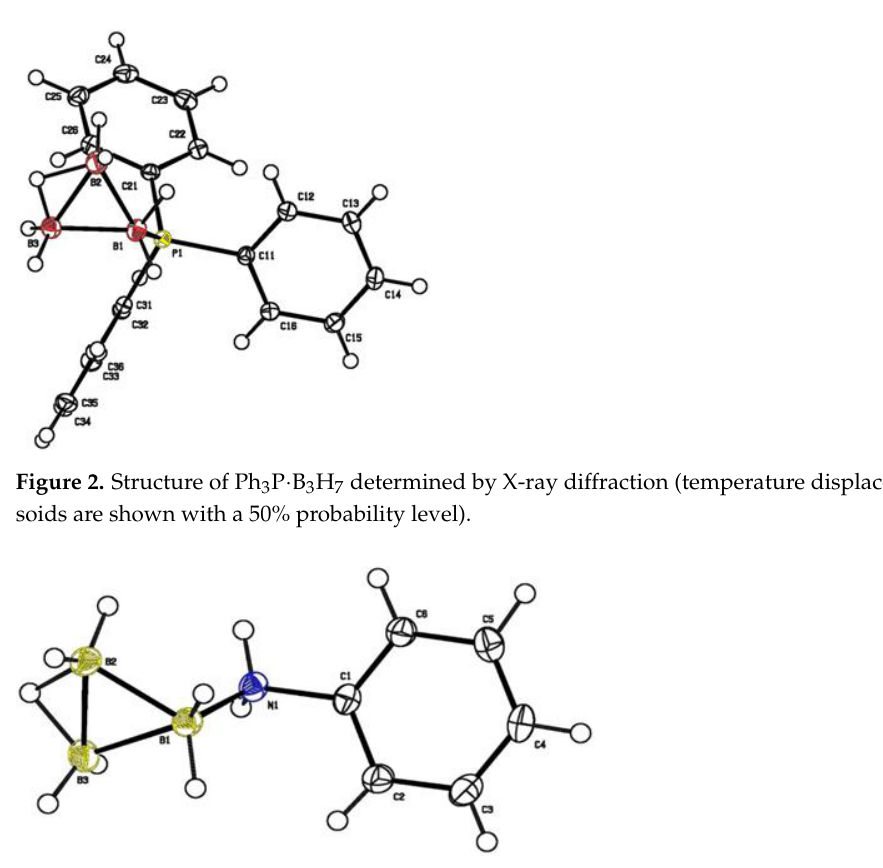
Figure 3. Structure of PhNH 2 · B 3 H 7 determined by X-ray diffraction (temperature displacement ellipsoids are shown with a 50% probability level). Table 1. The structural data obtained for Ph 3 P·B 3 H 7 and PhNH 2 ·B 3 H 7 .